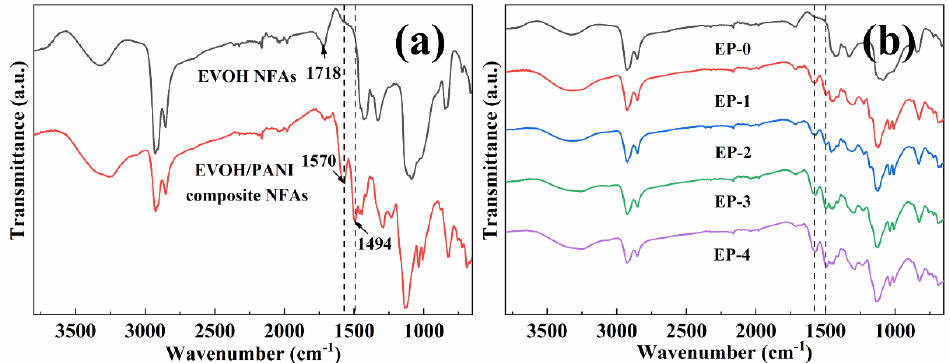
Figure 3. FTIR spectra: ( a ) EVOH NFAs and EVOH/PANI composite NFAs; ( b ) EVOH/PANI composite NFAs with various PANI nanorod contents.